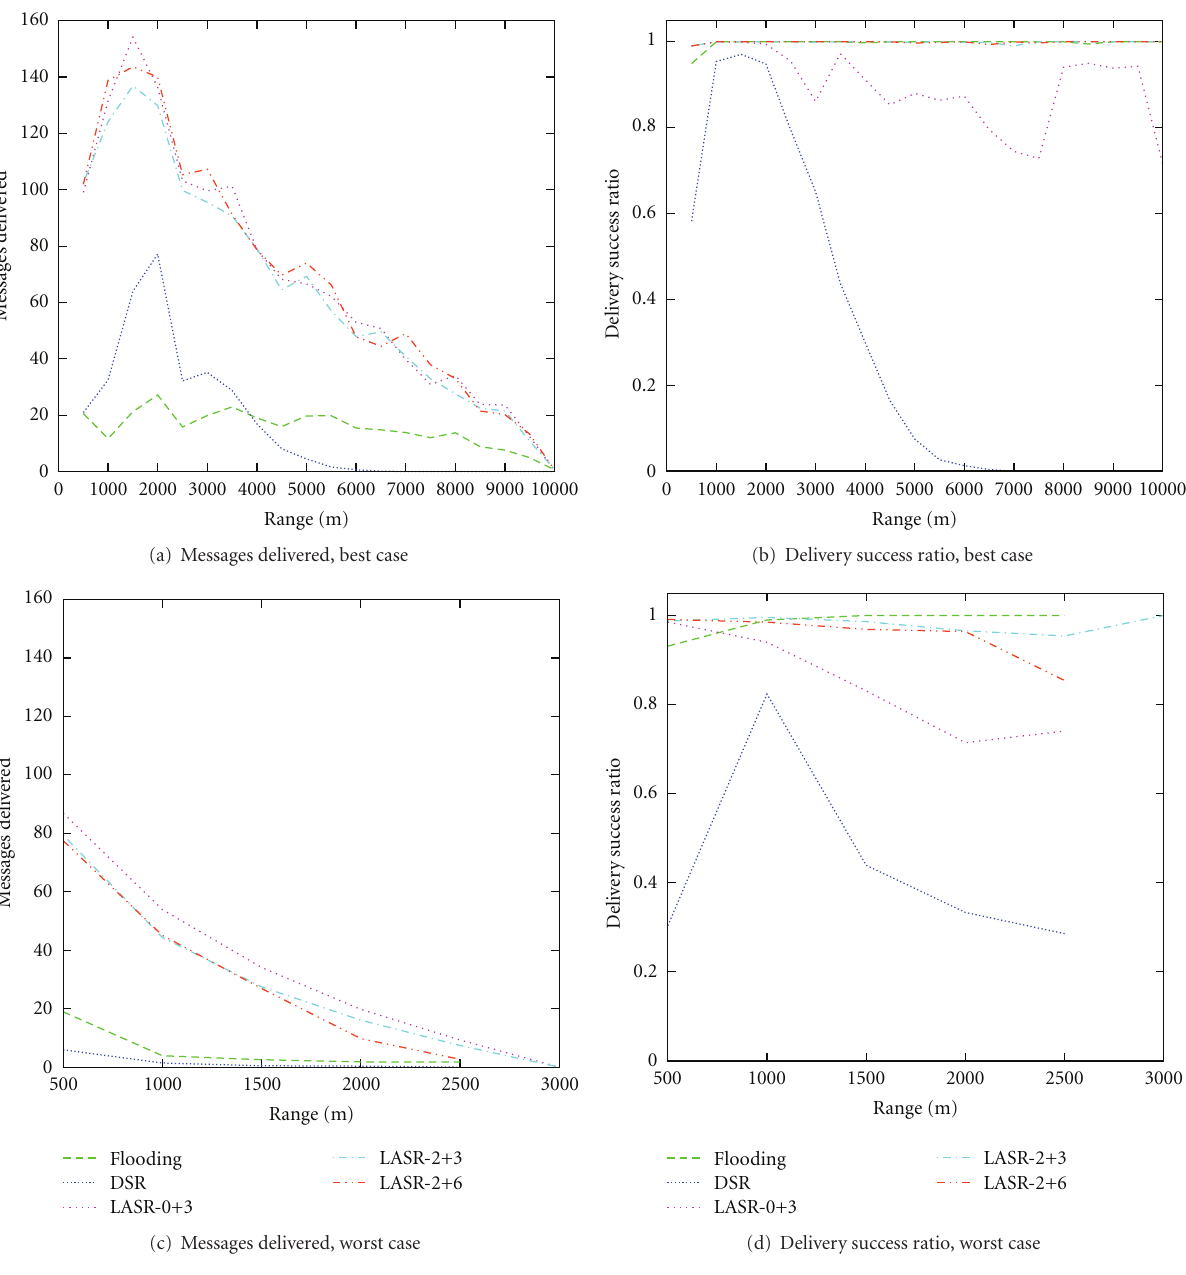
Figure 6: Messages delivered and message success: 16-vehicle spiral, FER NN ,max = 0 .